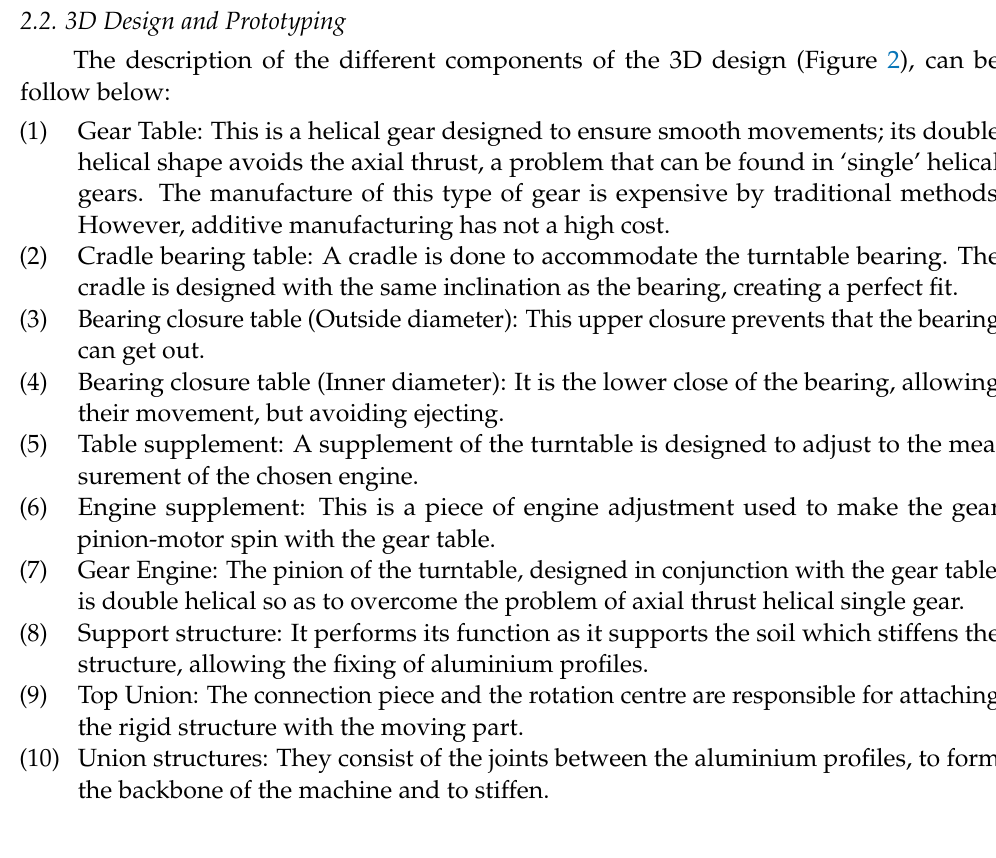
Figure 1. Conceptual Sketches. (Source: self-made).